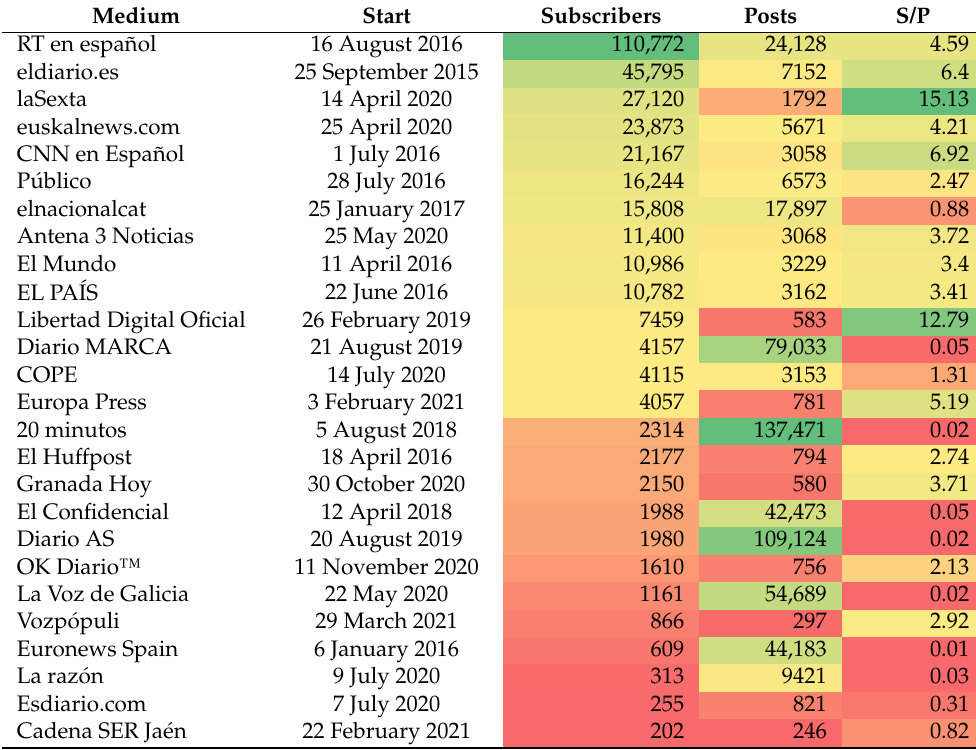
Table 2. Media ranking. Source: own